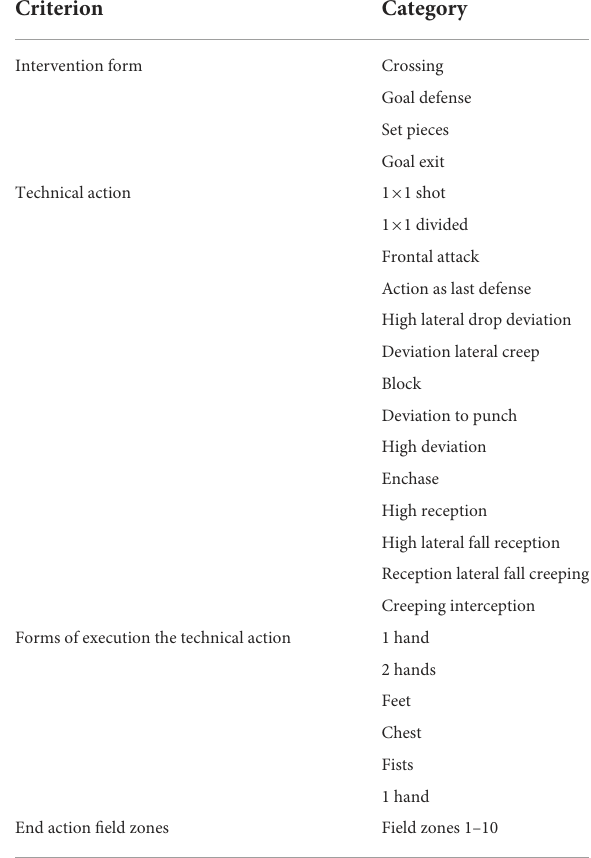
TABLE 1 Observational system of defensive technical-tactical